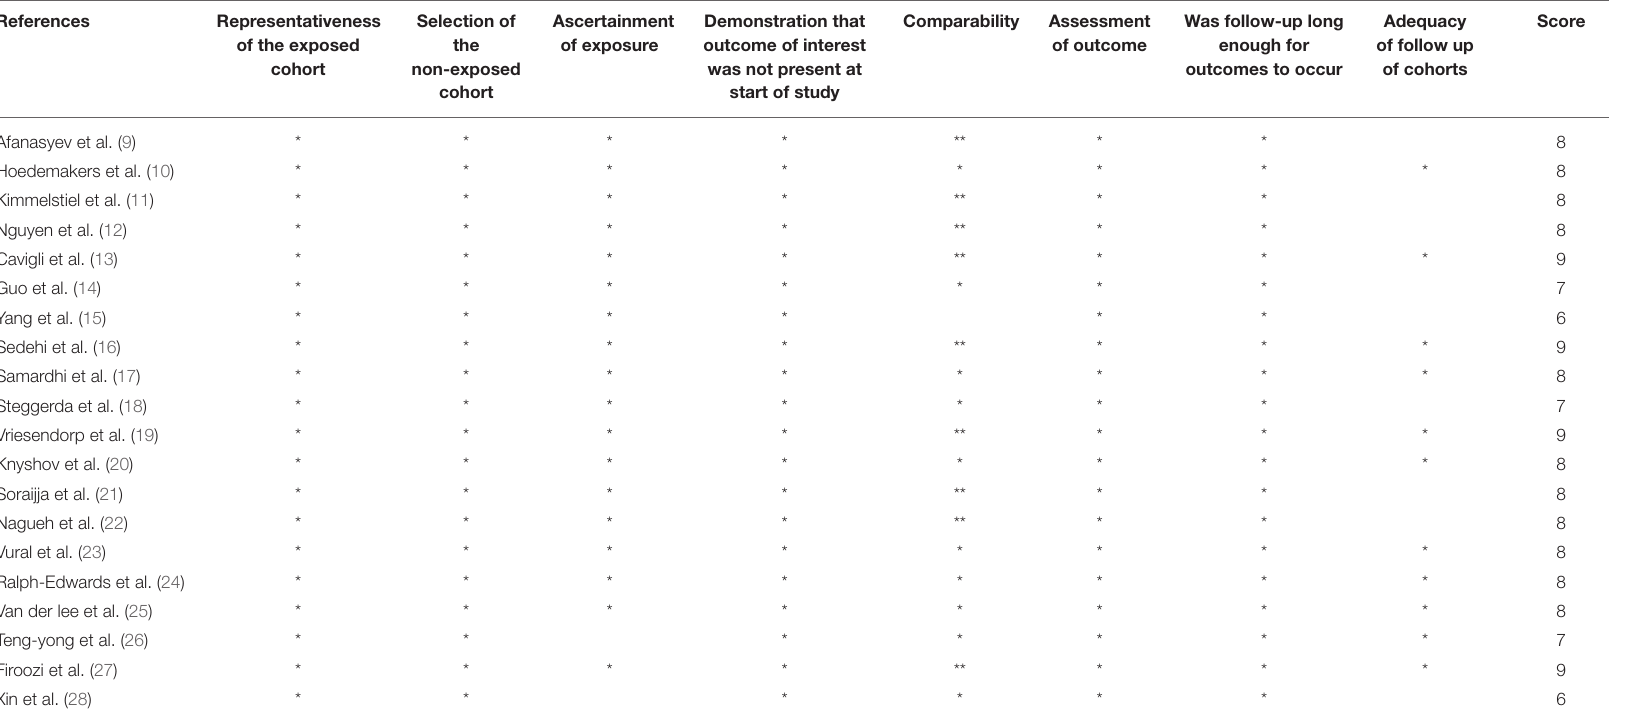
TABLE 1 | The scores of the 20 studies included in the meta-analysis assess by Newcastle-Ottawa Scale.